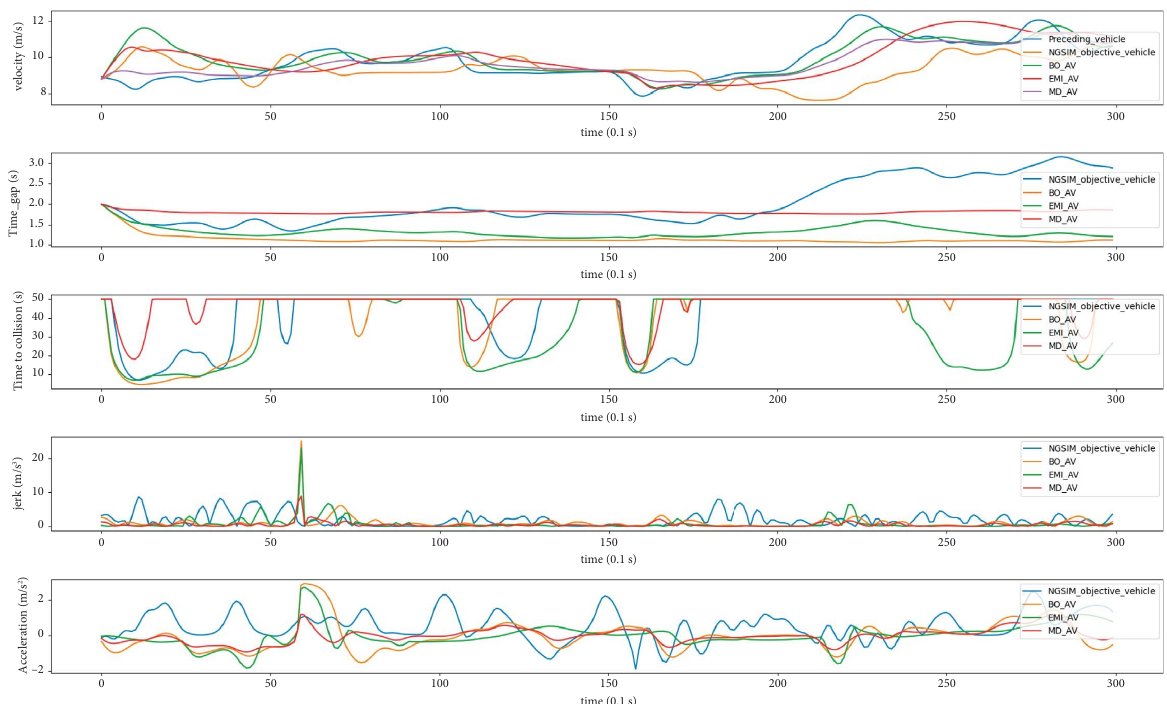
Figure 12: Randomly sampled data from NGSIM objective vehicle, DDPG (BO_AV), DDPG (EMI_AV), DDPG (MD_AV).